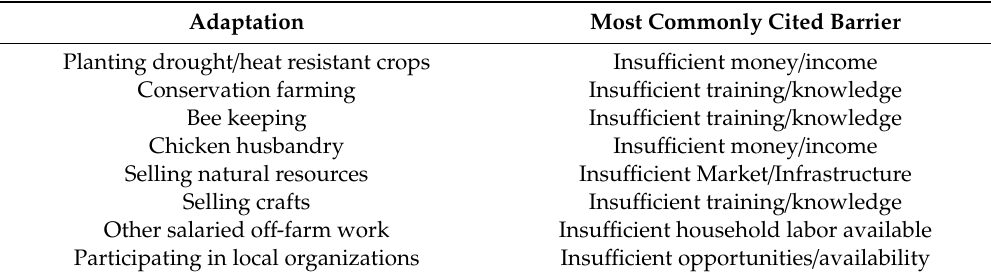
Table A1. List of the most commonly cited barriers of adaptation for each adaptation